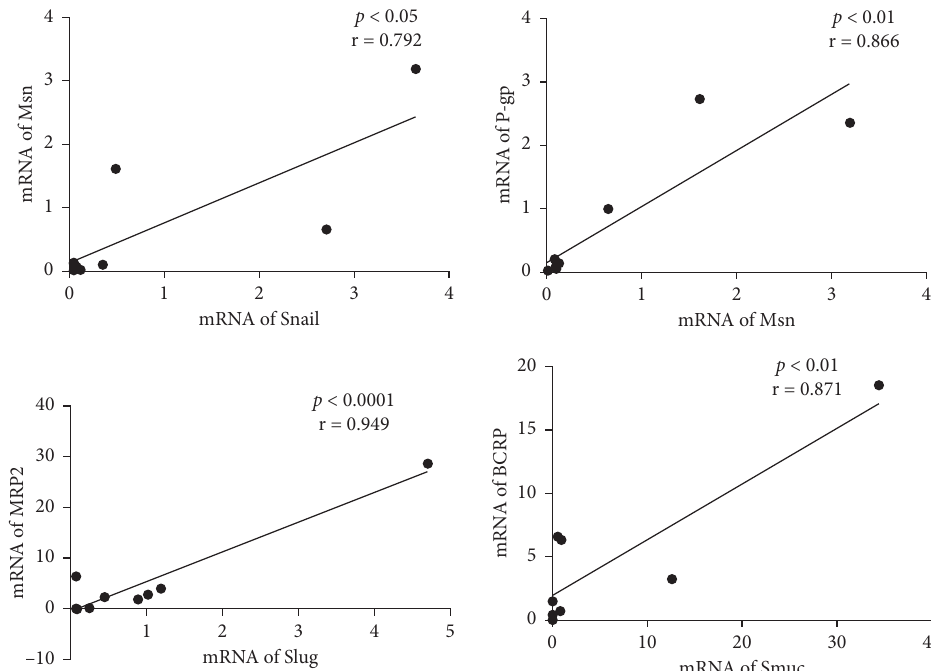
Figure 2: Correlations of relative mRNA expression levels of Snail and Msn, Msn and P-gp, Slug and MRP2, and Smuc and